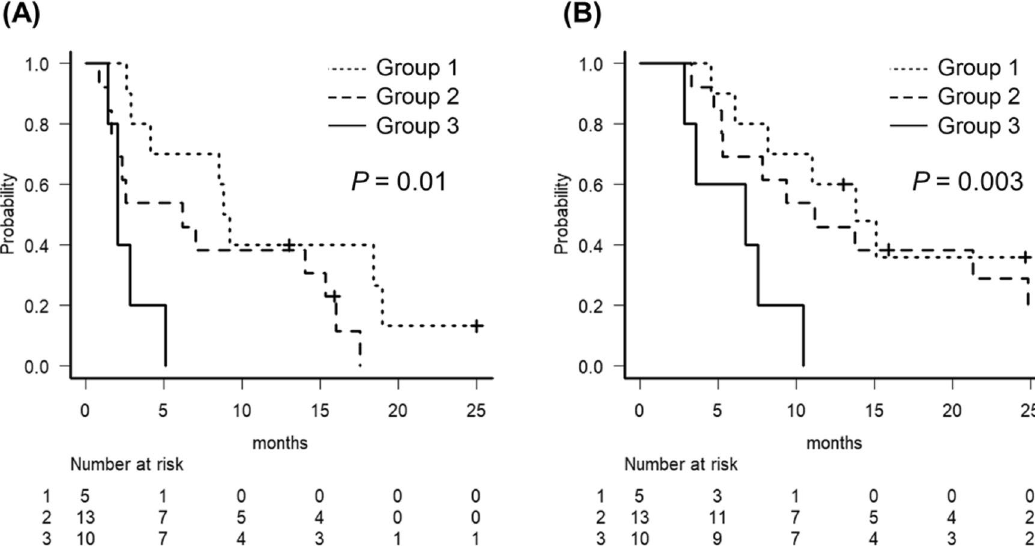
Figure 4. Kaplan–Meier curves of stromal CD8 + TIL combined with PD-L1. High stromal CD8 + TIL and PD-L1 positive subgroup were classified as class1 1, Low stromal CD8 + TIL and PD-L1 negative group were classified as class 3, the other staining group were classified as class2 2. ( A ) PFS curve. ( B ) OS curve.